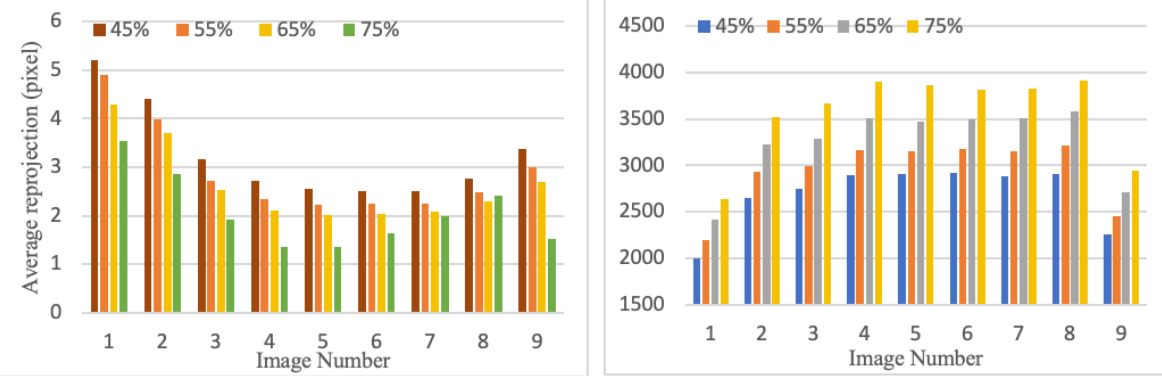
Figure 12. Results for the convergent block image orientation: average re-projection error of the bundle adjustment for each image (a) and number of tie points